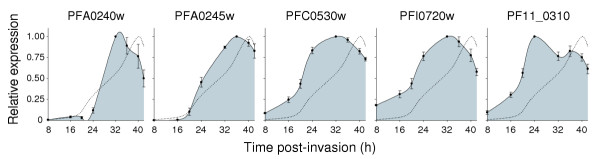
Stage-dependent gene expression of the five members of the novel putative transporter family, throughout the intraerythrocytic cycle of P. falciparum. The analysis was carried out as described in the legend to Figure 4.